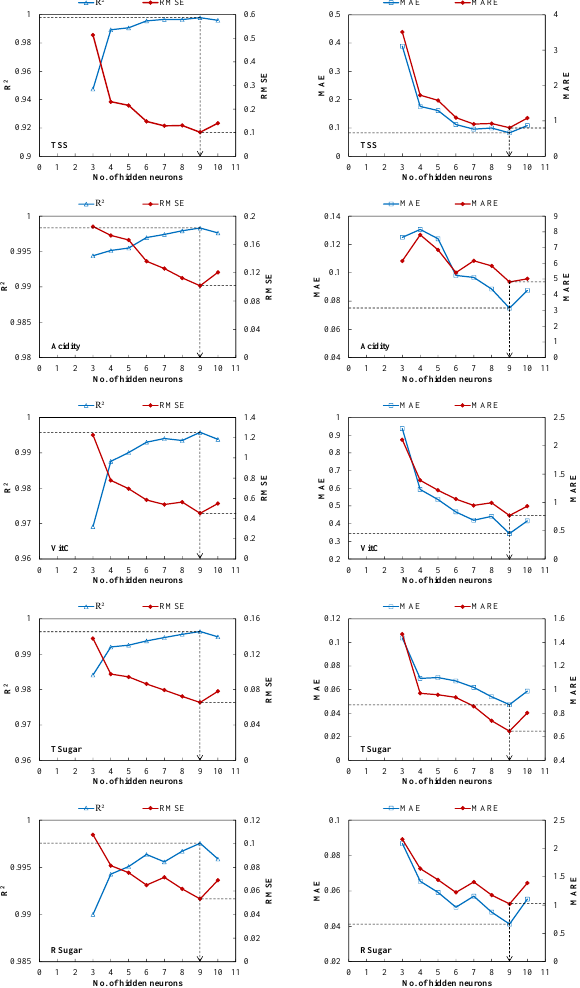
Figure 2. Number of hidden neurons verse statistical performance of the ANN model for total soluble solids (TSS), acidity, vitamin C (VitC), total sugars (Tsugar), and reducing sugars (Rsugar) during the stage of ANN configuration optimization. R 2 , coefficient of determination; RMSE, root mean square error; MAE, mean absolute error; MARE, mean absolute relative error.